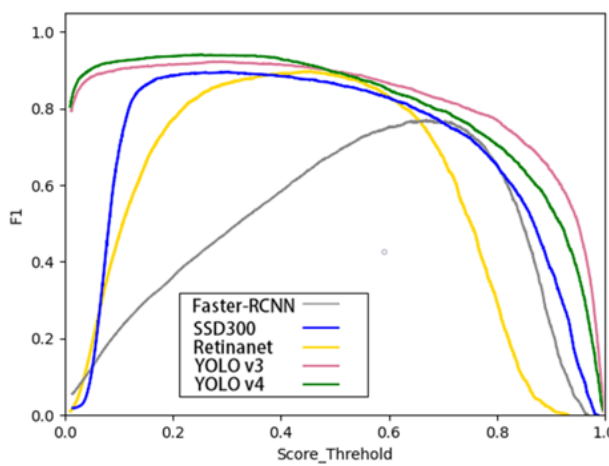
Figure 8. The F1 score curves of different algorithms.